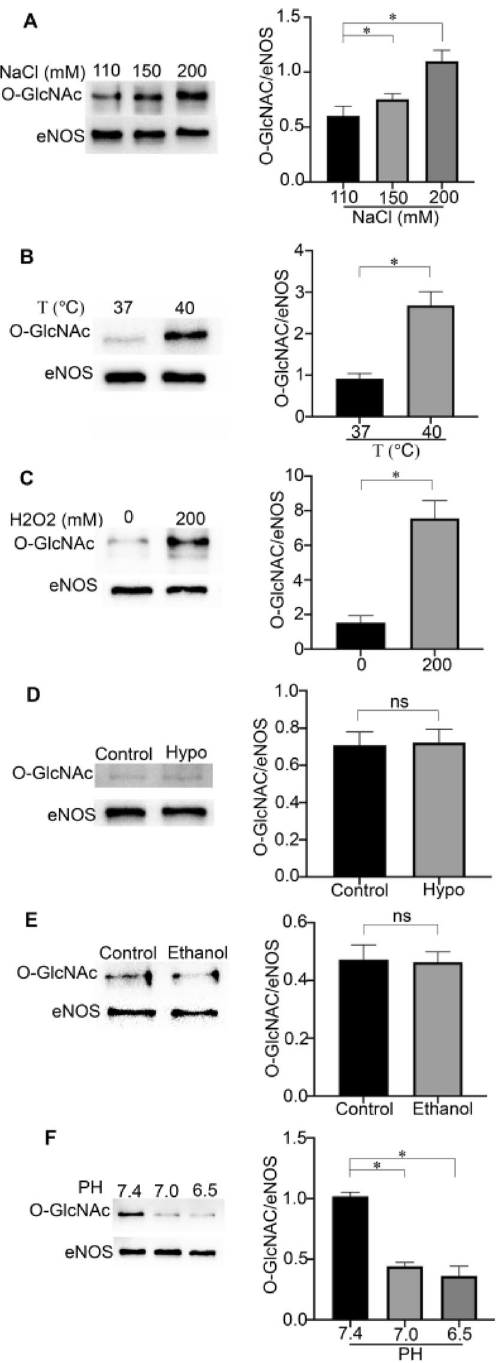
Figure 1. Effects of physical and chemical factors on eNOS O-GlcNAc in HEK293 cells transfected with WT-eNOS. ( A ) High NaCl increased the ratio of O-GlcNAc/eNOS in HEK293S cells. Typical images and statistical graphs are shown, n = 3. ( B ) Hyperthermia increased the ratio of O-GlcNAc/eNOS in HEK293 cells. Typical images and statistical graphs of the ratio of O-GlcNAc/eNOS in HEK293 cells, n = 3. ( C ) Hydrogen peroxide increased the ratio of O-GlcNAc/eNOS in HEK293 cells. Typical images and statistical graphs are shown, n = 3. ( D ) Hypoxia had no effect on the ratio of O-GlcNAc/eNOS in HEK293 cells. Typical images and statistical graphs are shown, n = 3. ( E ) Ethanol had no effect on the ratio of O-GlcNAc/eNOS in HEK293S cells. Typical images and statistical graphs are shown, n = 3. ( F ) The decrease in pH reduced the ratio of O-GlcNAc/ eNOS in HEK293 cells. Typical western blot images are shown in the left panel. The statistical results are shown in the right panel; Full-length blots are presented in Supplementary Figure S1A, S2B, S3C, S4D, S5E, S6F. n = 3. *P < 0.05. ns indicates no